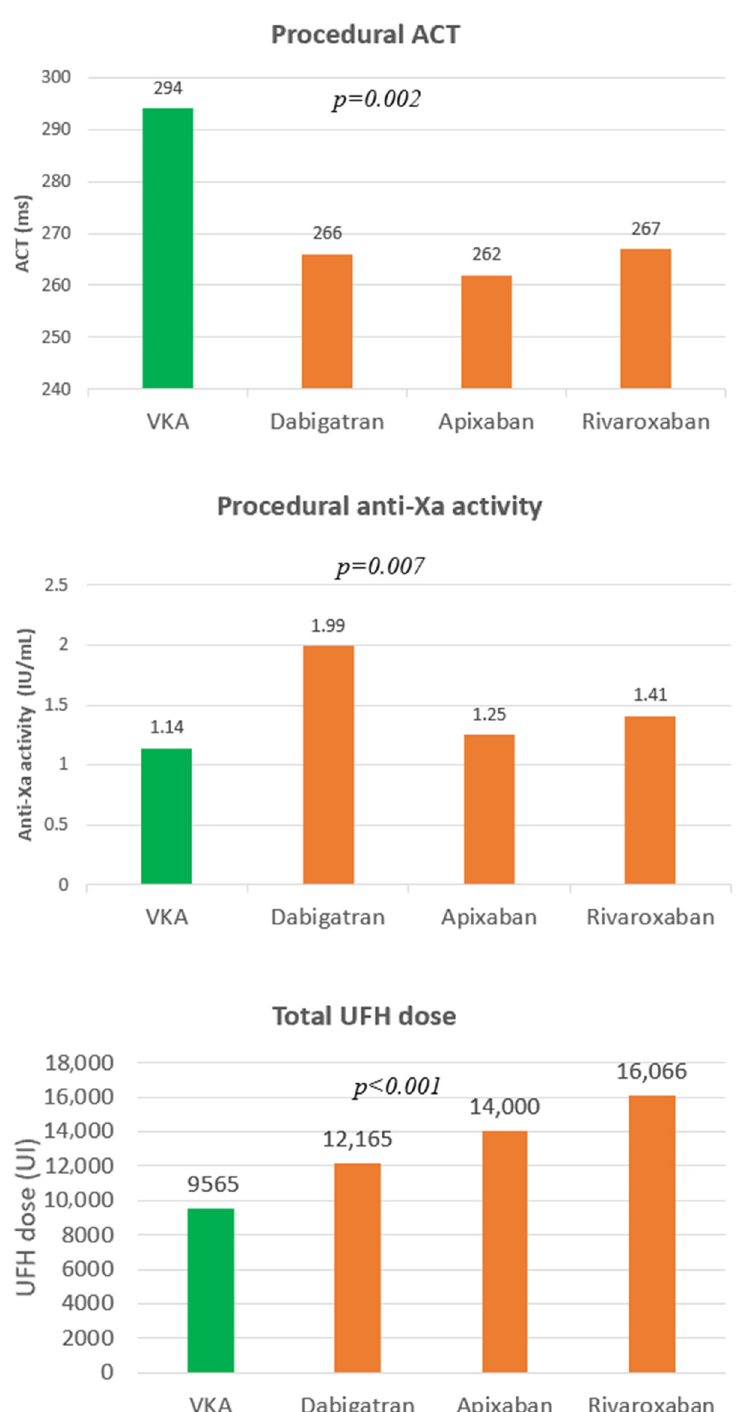
Figure 2. Mean ACT, anti-Xa activity, and UFH dose depending on anticoagulant type. The p -values represent those of the respective tests between VKA and DOACs groups.